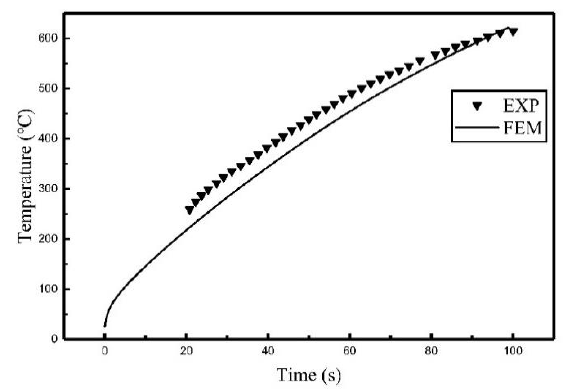
Figure 15. The temperature histories of C 3 during the multi-coil experiment and simulation.